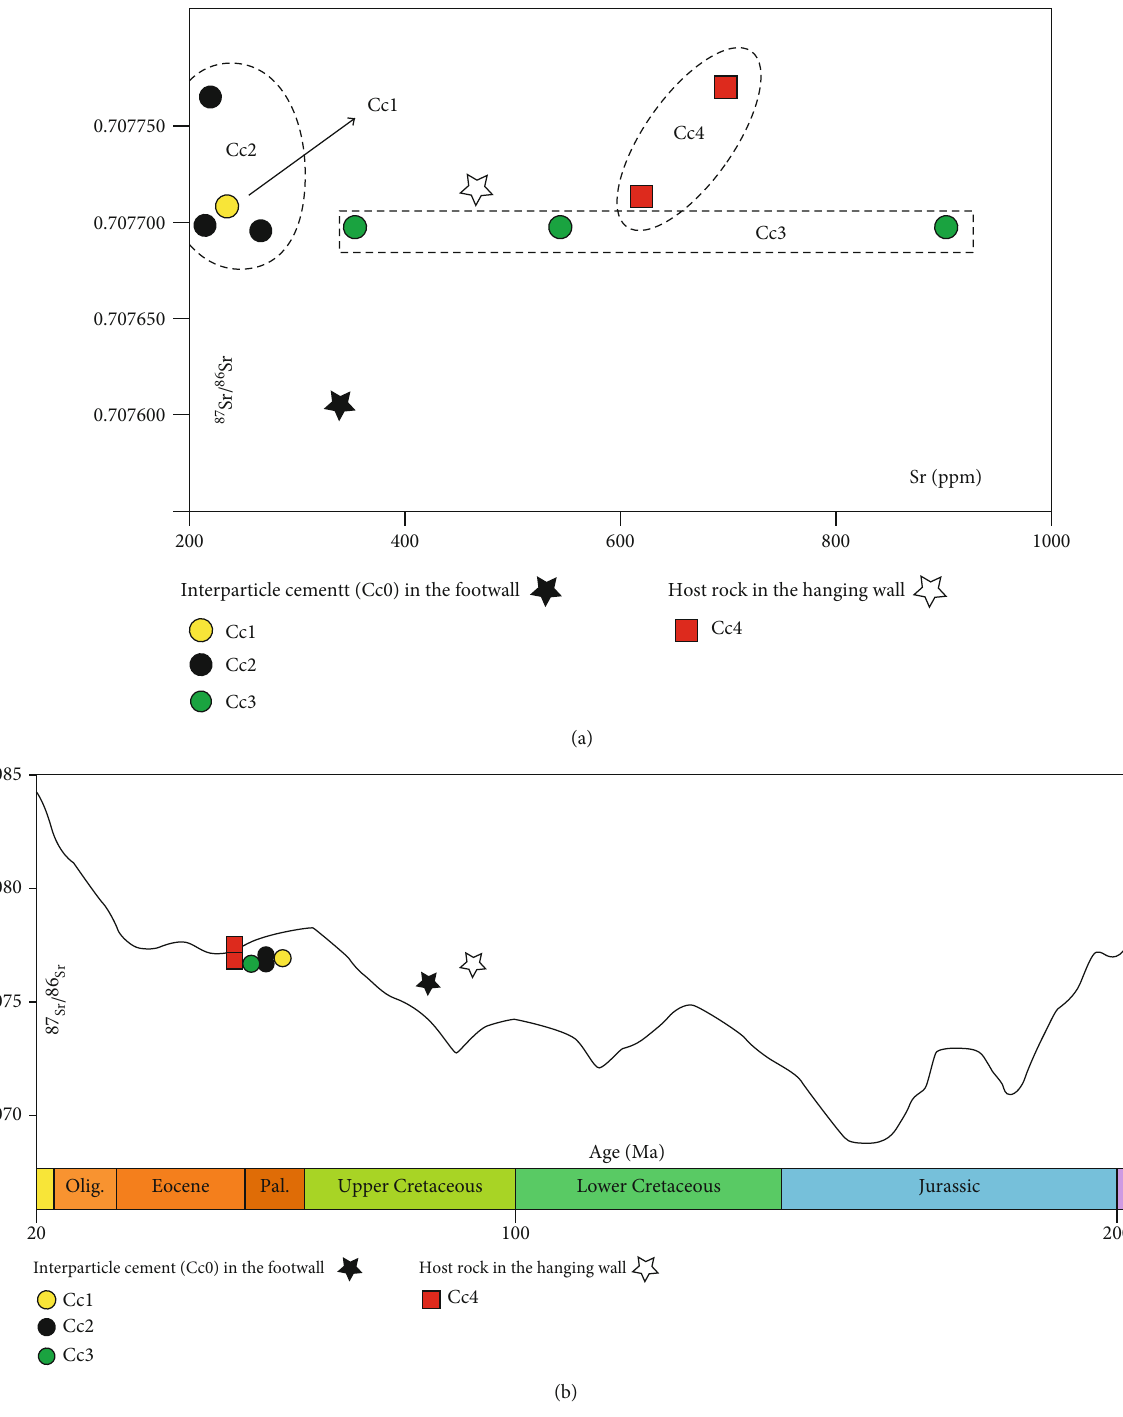
Figure 11: (a) 87 Sr/ 86 Sr isotopic ratios of calcite cements and host carbonates plotted against the Sr content. (b) 87 Sr/ 86 Sr ratios compared with the 87 Sr/ 86 Sr isotopic ratios of seawater through time from the LOWESS curve